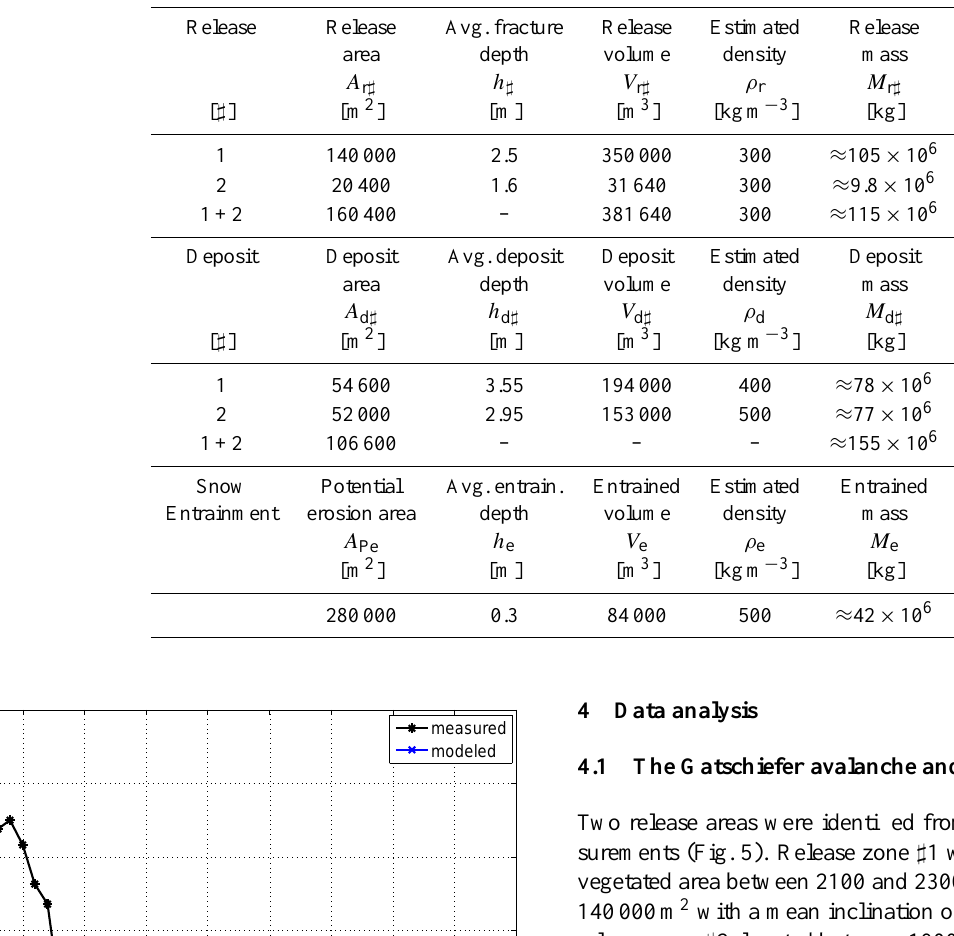
Table 1. The Gatschiefer avalanche mass balance.